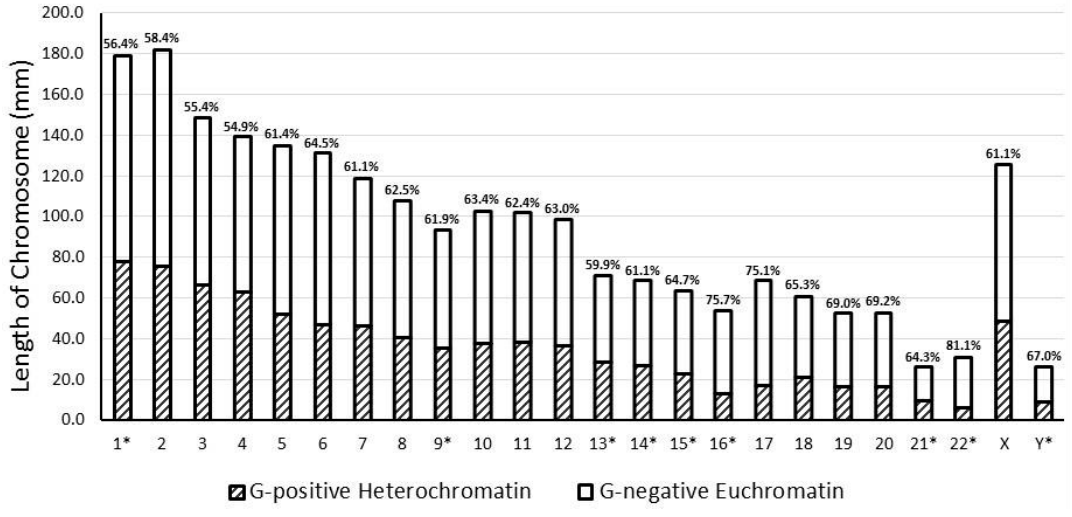
Figure 3. Giemsa band distributions as a proportion of chromosome length. * = Length of qh, centromeric and/or acrocentric chromosome p arm regions were excluded. Percentage above bar for each chromosome represents the proportion of G-negative euchromatin per chromosome.